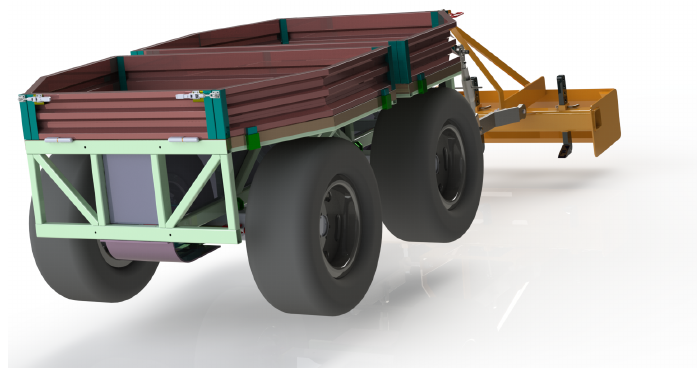
Figure 11. A 3D rendering of the